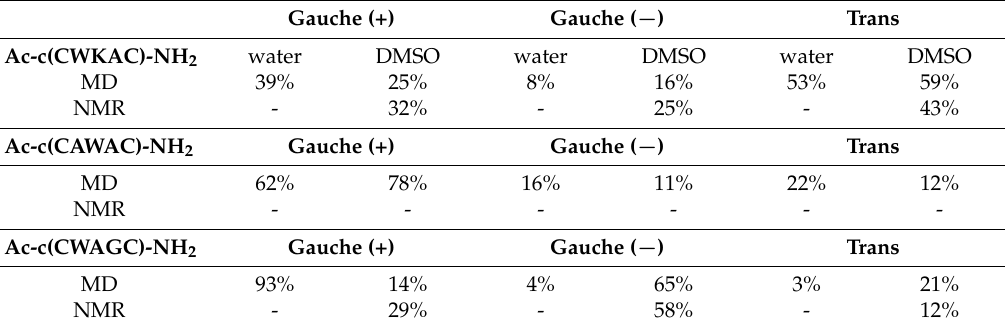
Table 4. Analysis of Trp side-chain conformation in terms of the population of three staggered rotamers ( gauche (+)/( − ) and trans ). Comparison of MD and NMR